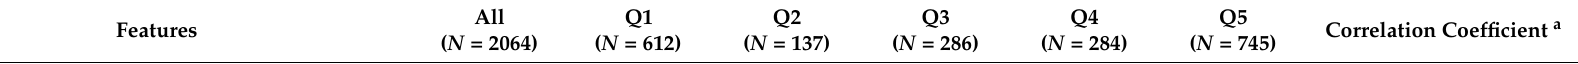
Table 3. Green space features according to neighbourhood socioeconomic deprivation